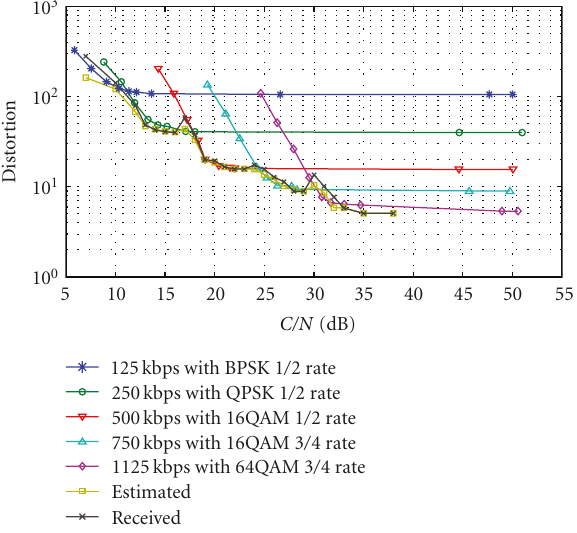
Figure 22: Distortion comparison, table , GOP number 15, initial mode = 3, Set